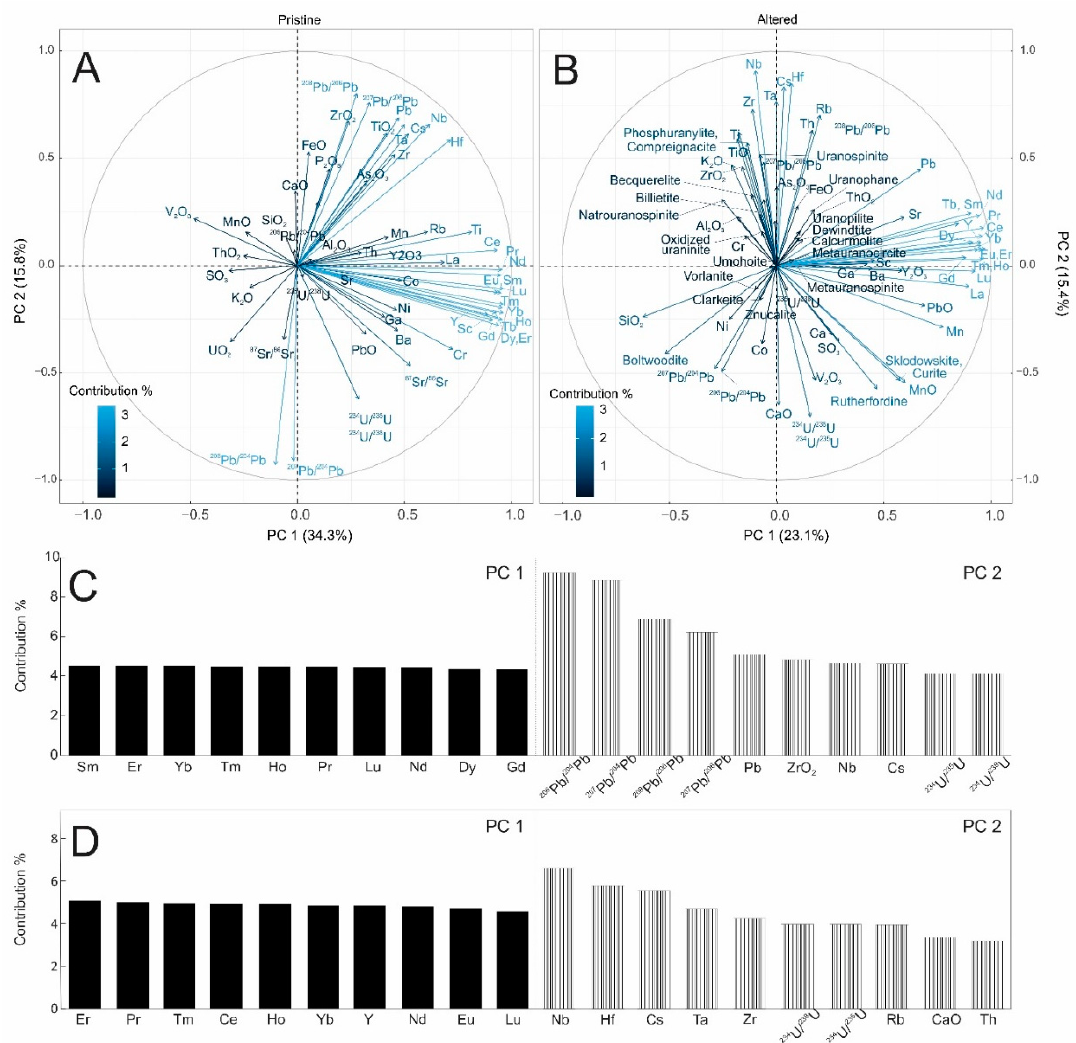
Figure 8. Variable contribution for ( A ) pristine and ( B ) altered principal component analysis using all variables (Figure 7). The % each variable contributes is illustrated by the length and color of the individual vector with the longer the vector and lighter the color, the more that particular vector (variable) influences either PC1 or PC2. The top 10 variables that contribute to PC 1 and PC 2 for pristine and altered are given in C and D, respectively (Table S5).